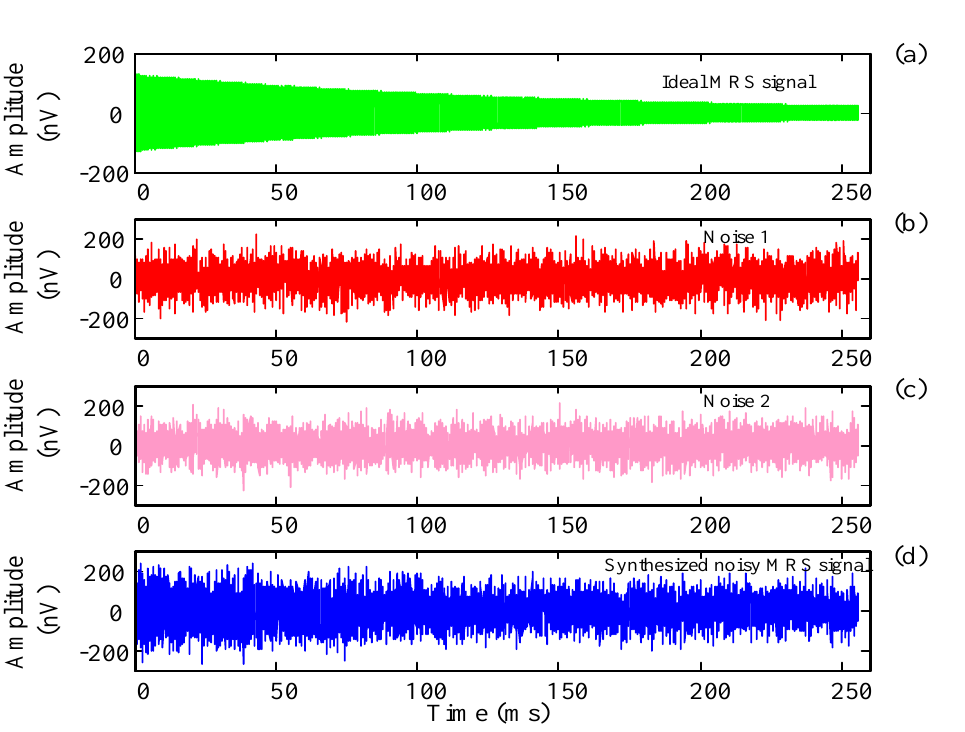
Figure 7. Simulation of noisy MRS signal. ( a ) The ideal MRS signal without noise; ( b ) the simulated noise 1; ( c ) the simulated noise 2 for MFSS; ( d ) the simulated noisy MRS signal with the noise 1.